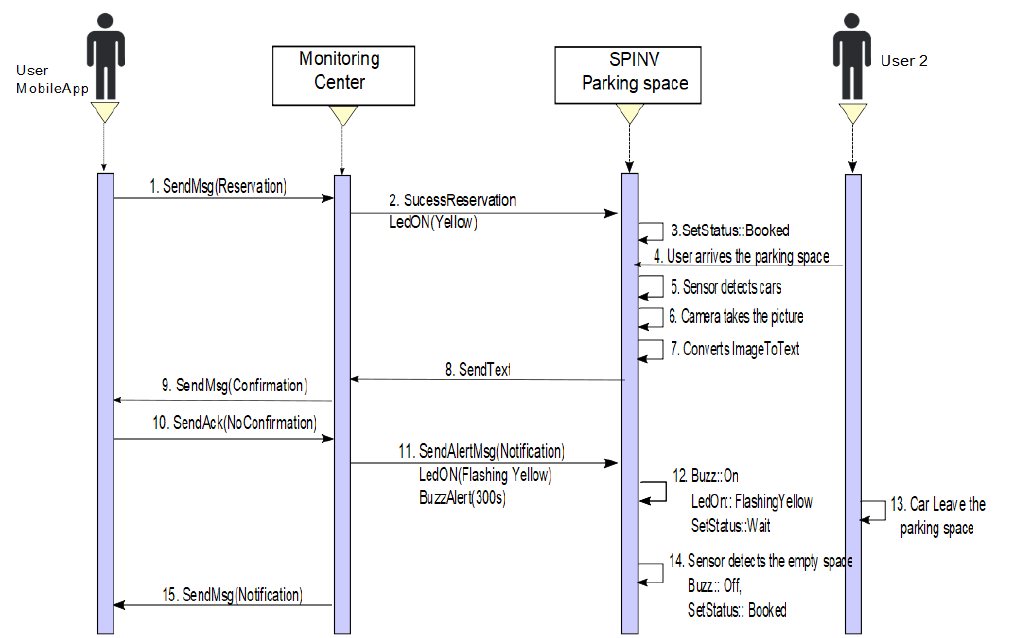
Figure 7. Sequence diagram of Scenario 2a. Reserve/someone else park in the space and the car leaves the